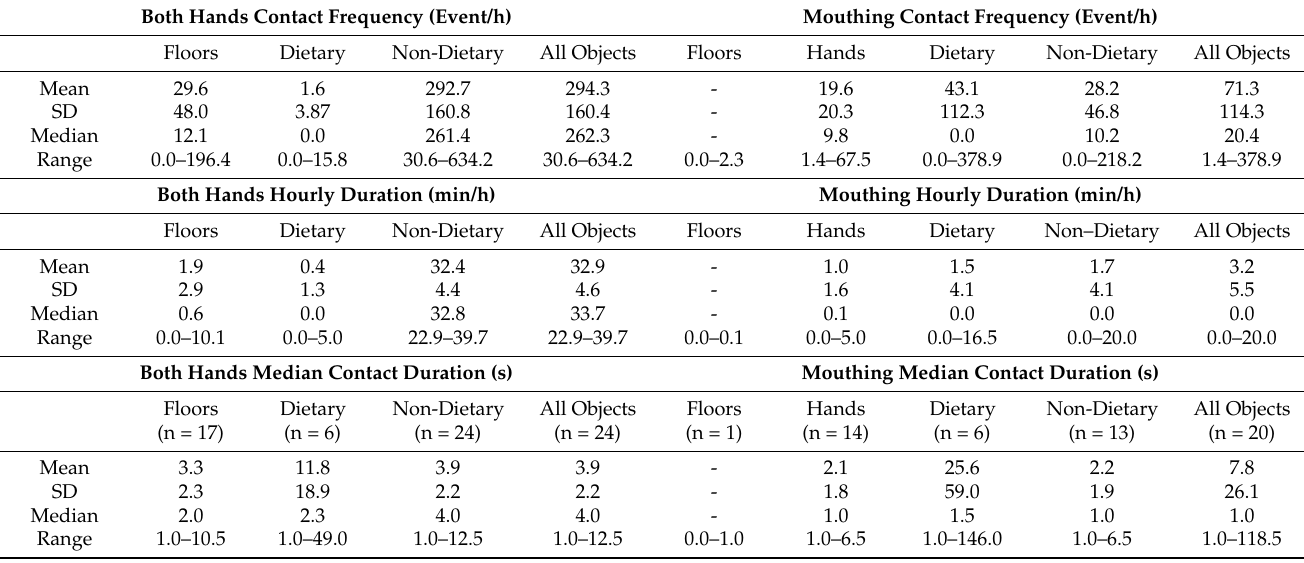
Table 4. Both hands and mouthing activity frequency, hourly duration, and median duration of children on playgrounds (n =